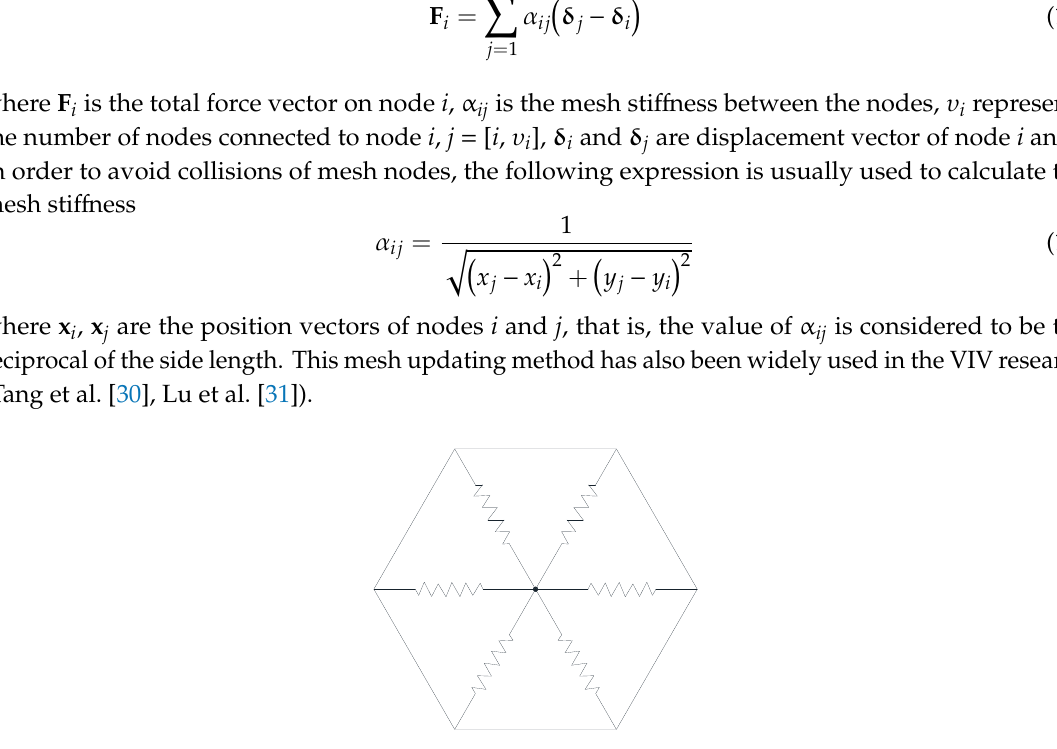
Figure 3. Illustration of the elastic mesh.